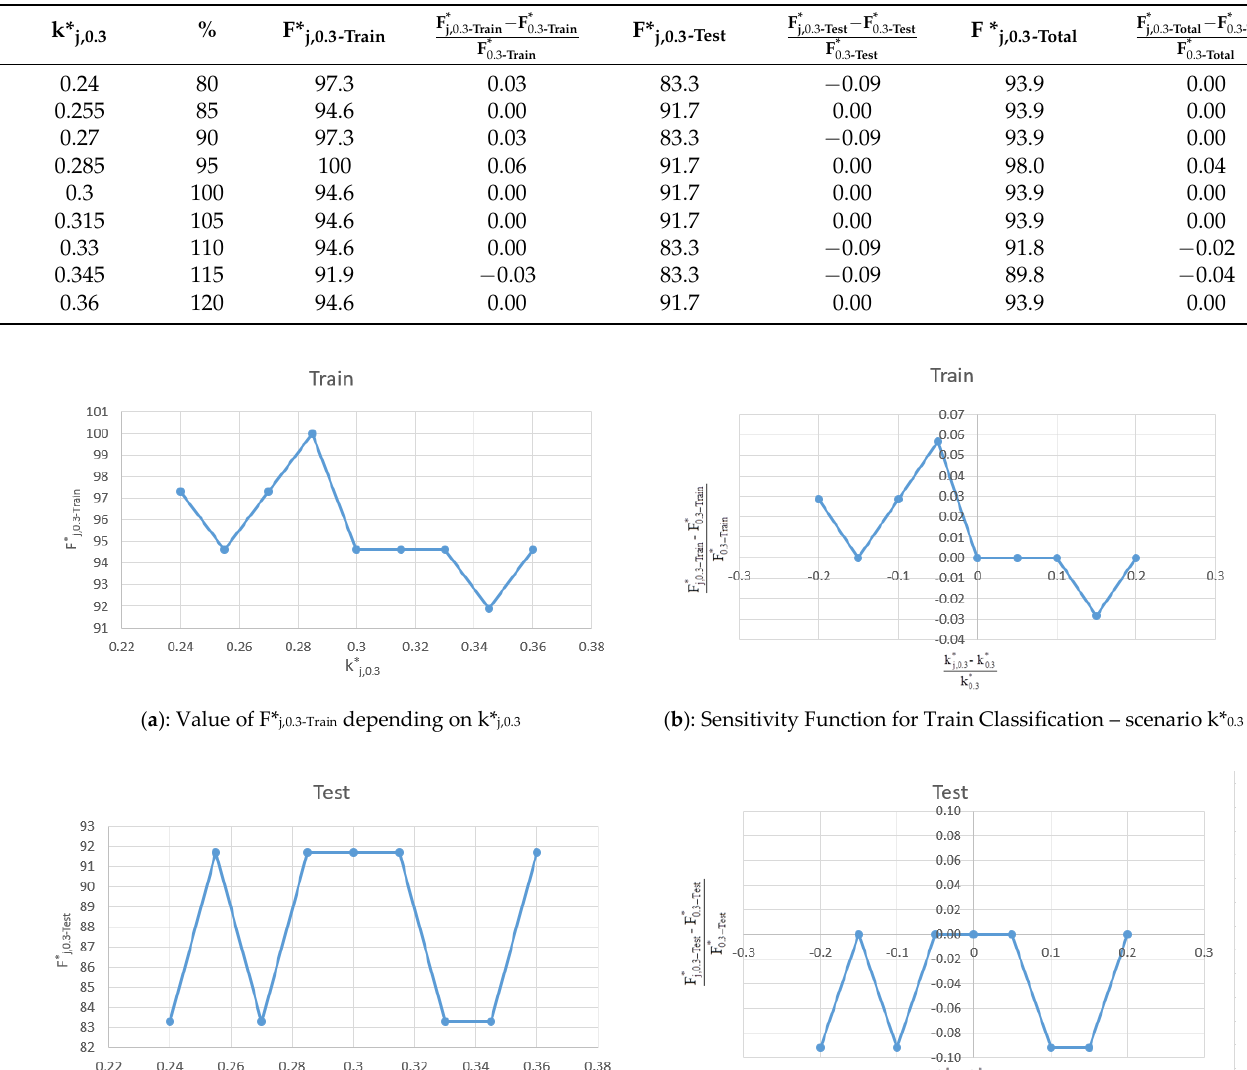
Table 5. Values of F* j,0.30-Train , F* j,0.30-Test , and F* j,0.30-Total by varying k* 0.30 in the fixed range. k* j,0.3